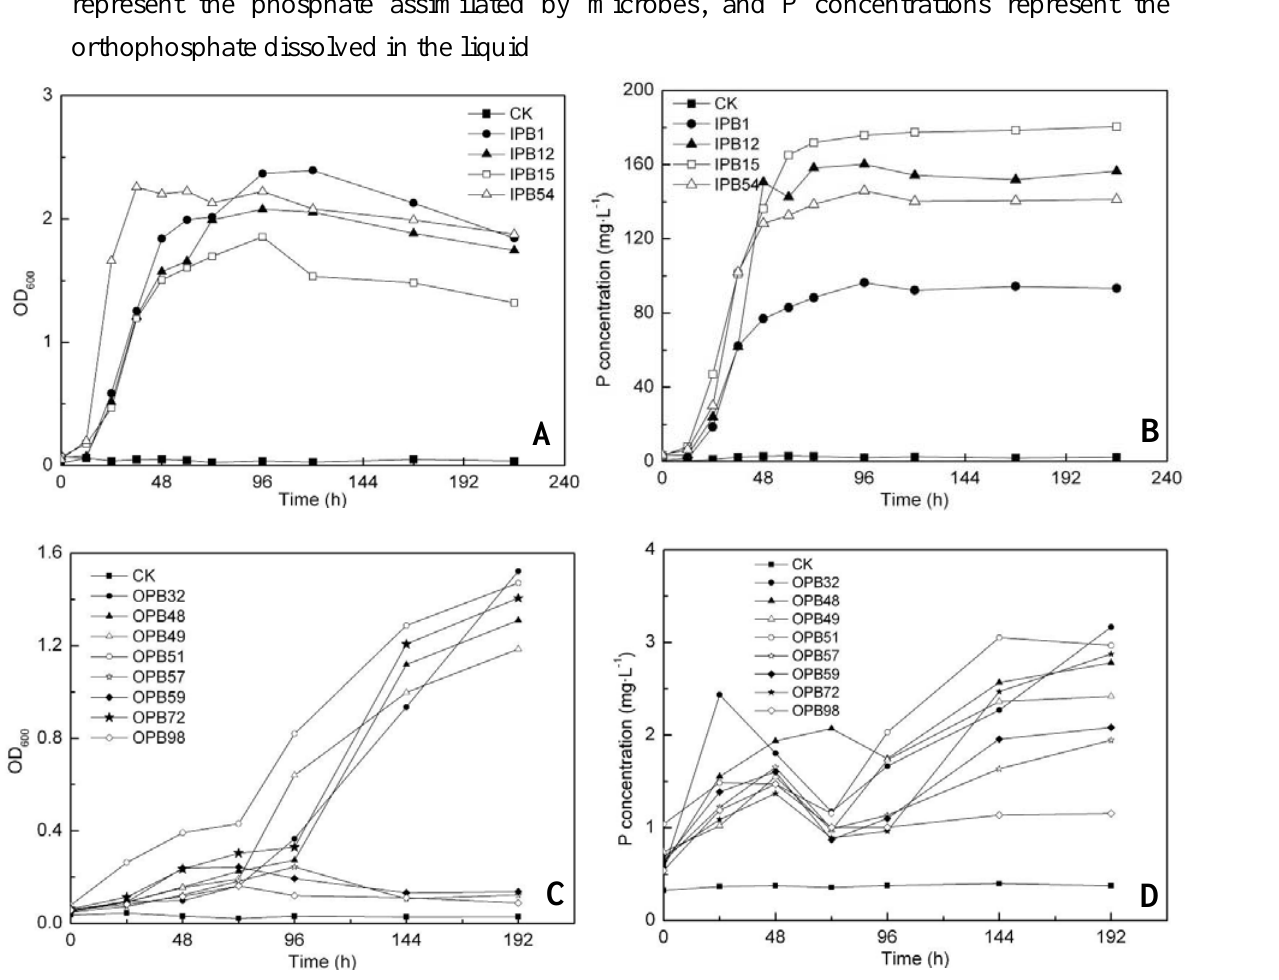
Figure 4. The calcium phosphate solubilizing abilities of IPBs and lecithin mineralizing abilities of OPBs. Bacterial growth is evaluated by OD represent the phosphate assimilated by microbes, and P concentrations represent the orthophosphate dissolved in the